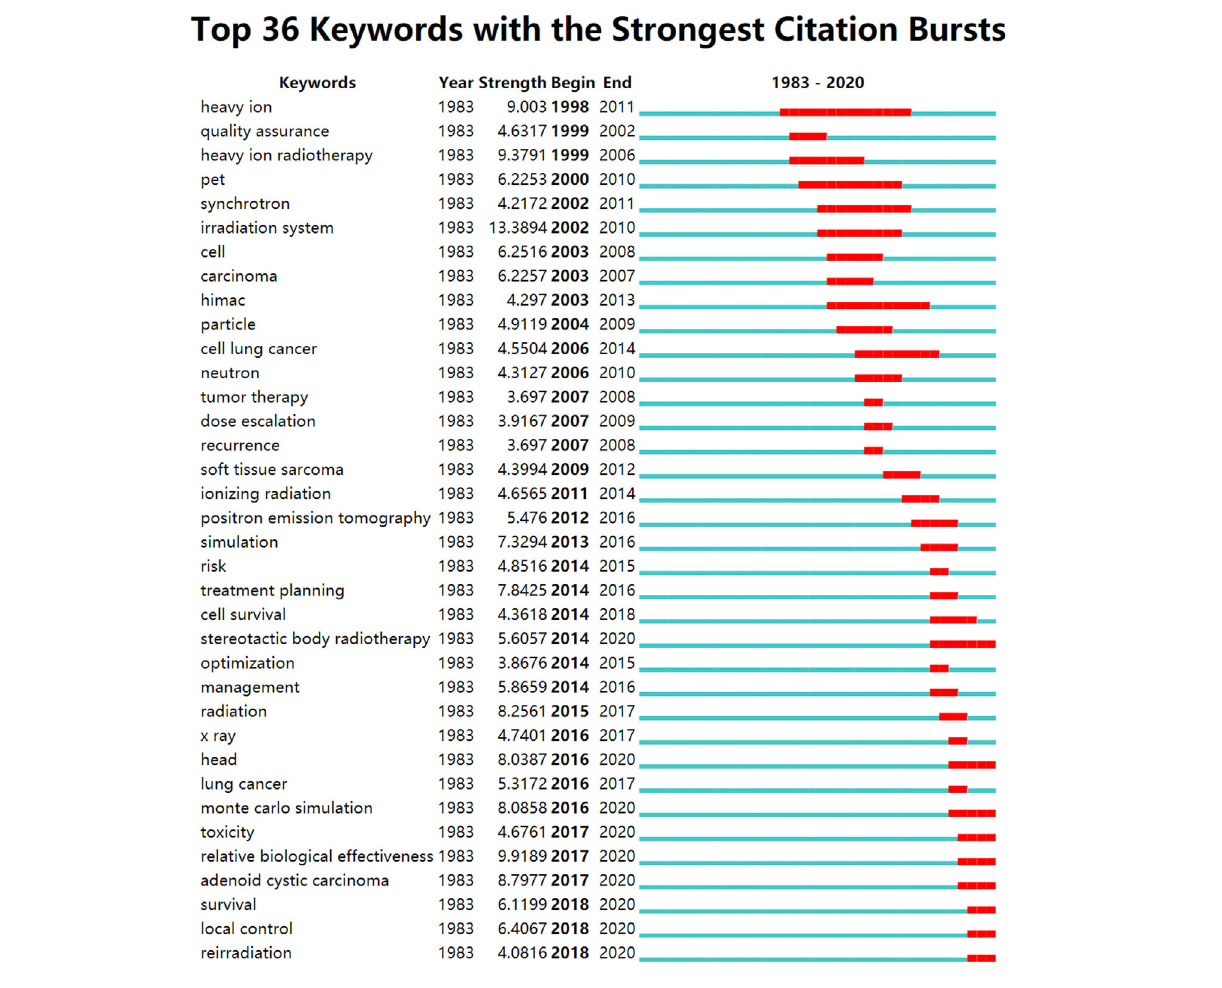
FIGURE 5 | Burst keywords of HIRT-related